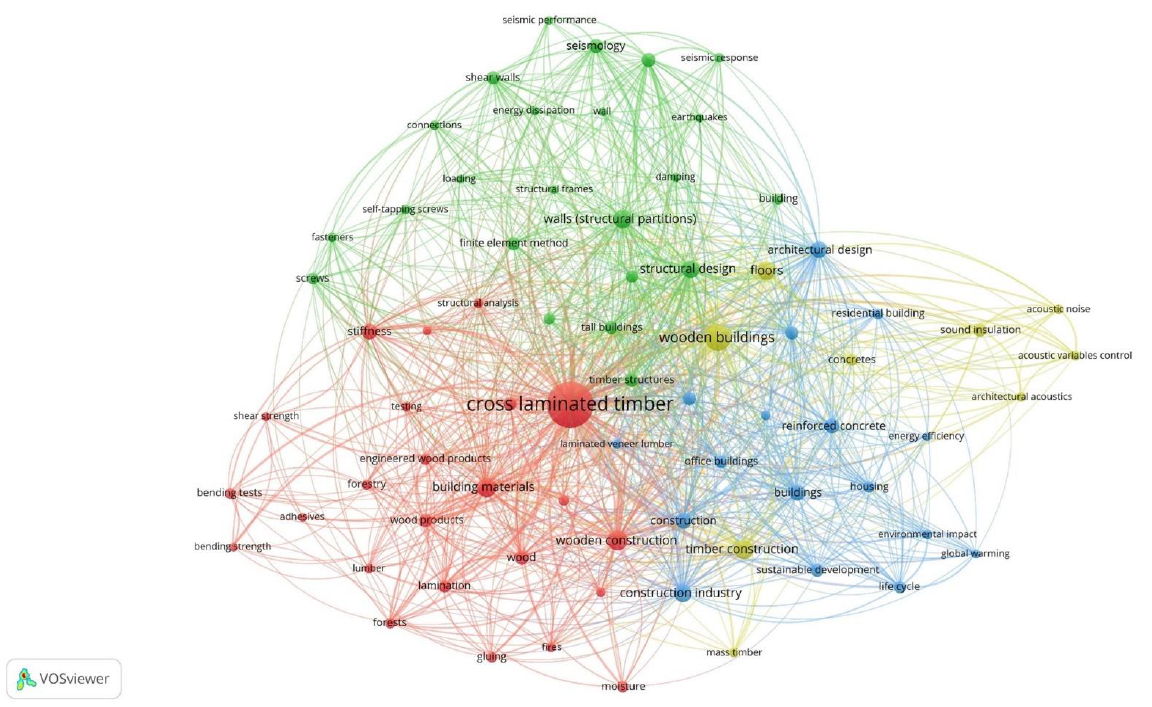
Figure 3. Network map of co-occurring keywords related to cross-laminated timber in construction (2006 – 2022).